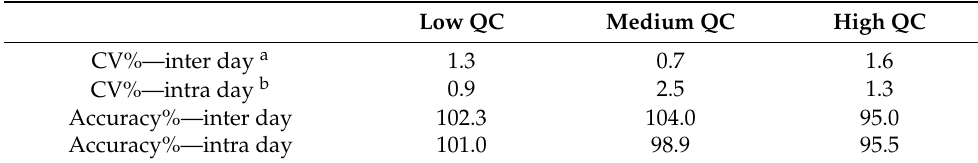
Table 1. Method accuracy and precision ( n =